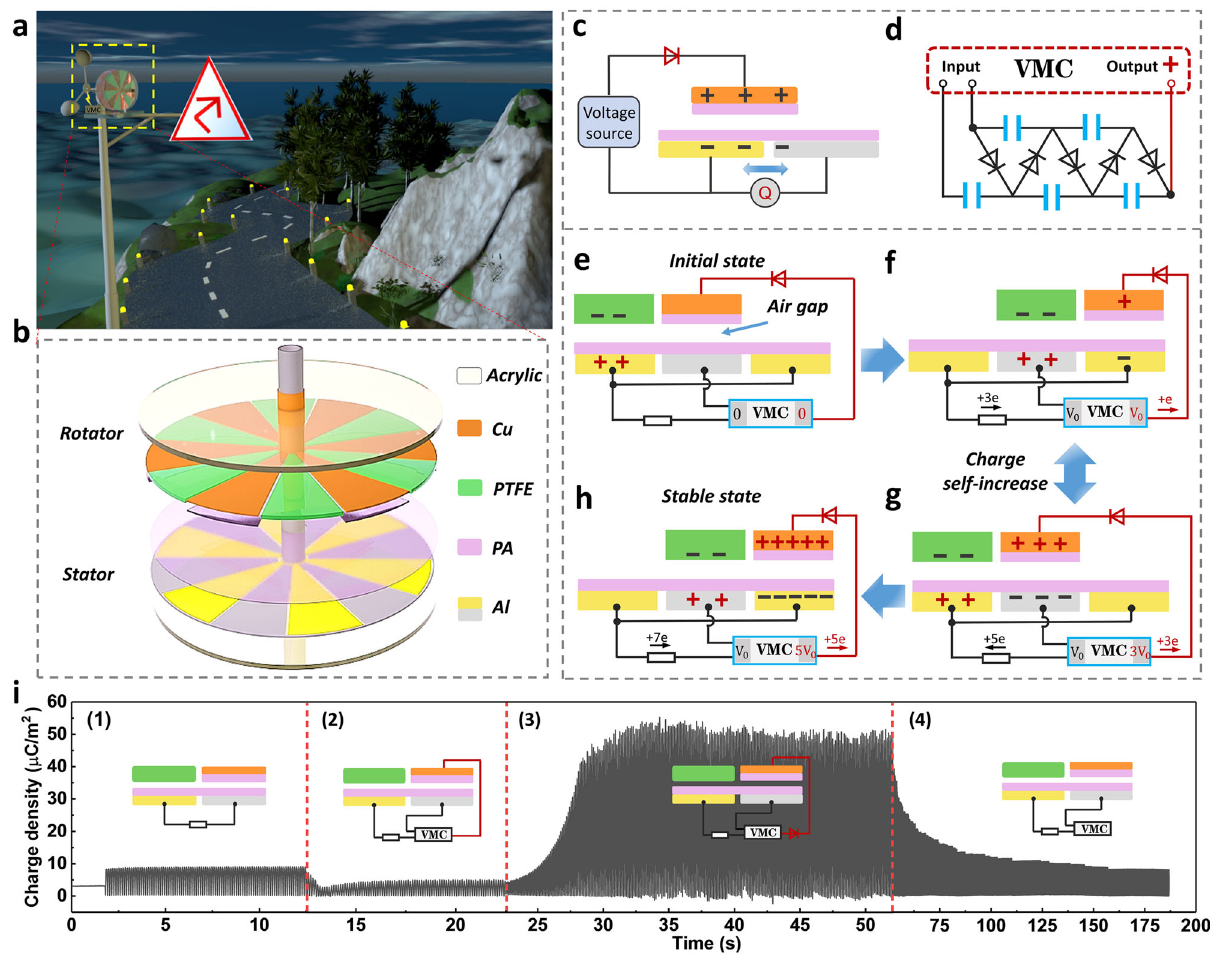
Fig. 1 Structure and working principle of the FSS-TENG. a Scene graph of the FSS-TENG for wind energy harvesting. b 3D structural schematic of the rotary FSS-TENG unit. c Simpli fi ed working schematic of the FSS-TENG. d The input/output node and scheme of the voltage-multiplying circuit (VMC). e – h The charge self-excitation process during periodically sliding cycle. i Dynamic output charge curve under four working modes, showing the powerful output boosting ability of our designed